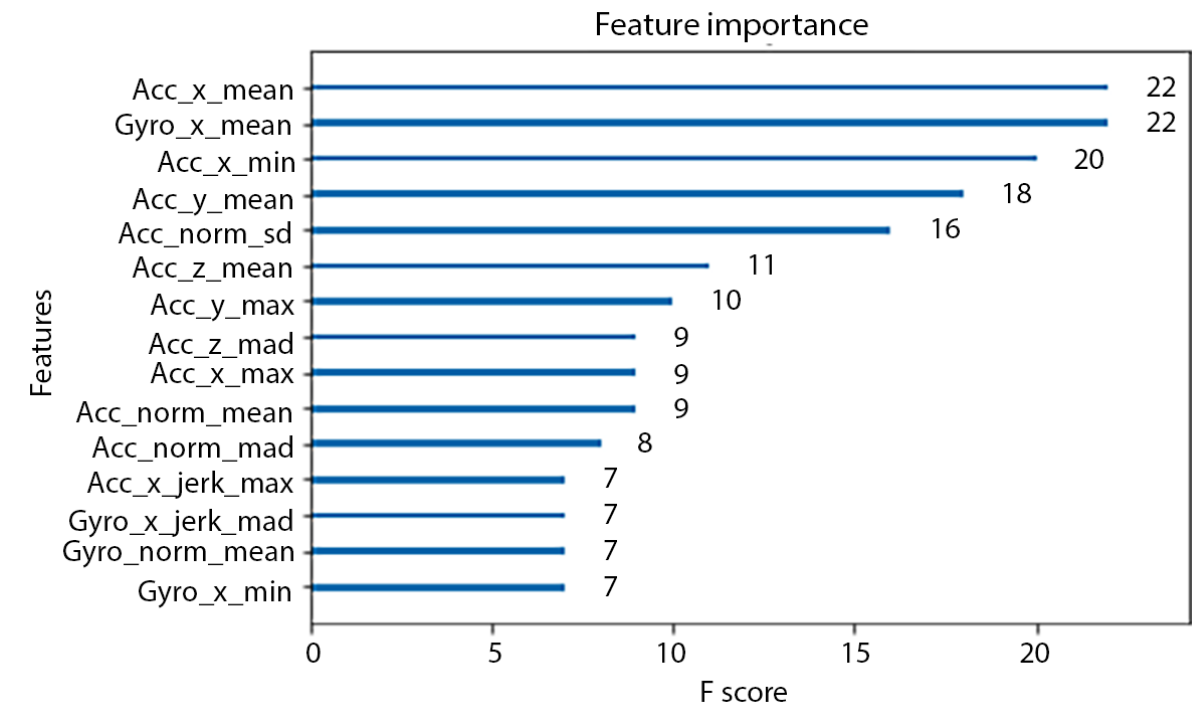
Figure 9. Importance of the top 15 features from Xgboost using greedy Gaussian segmentation from the human activity recognition using smartphones dataset. Abbreviations in the feature names are standard deviation (std), minimum (min), maximum (max), mean absolute deviation (mad), Euclidean magnitude (norm), and derivative (jerk). The operators in the names should be read in the order of from the right to the left. For example, acc_x_jerk_max means the maximum value of the derivative values on the x-axis of the accelerometer sensor. Acc: accelerometer; Gyro: